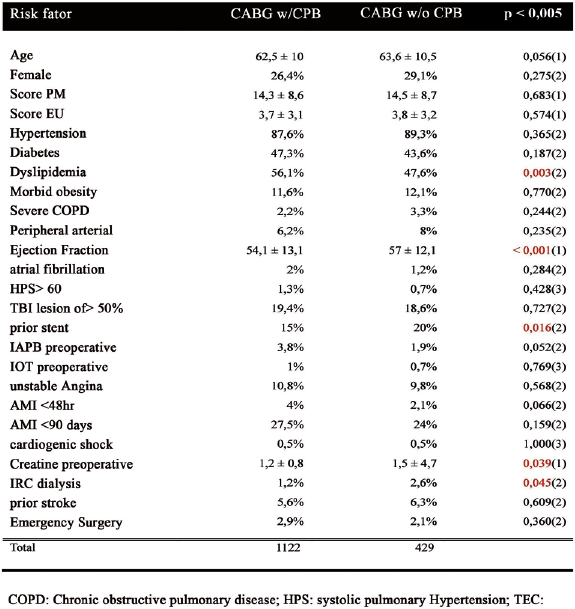
Fig. 1 - Prevalence of variables in patients with and without cardiopulmonary bypass for patients undergoing coronary artery bypass